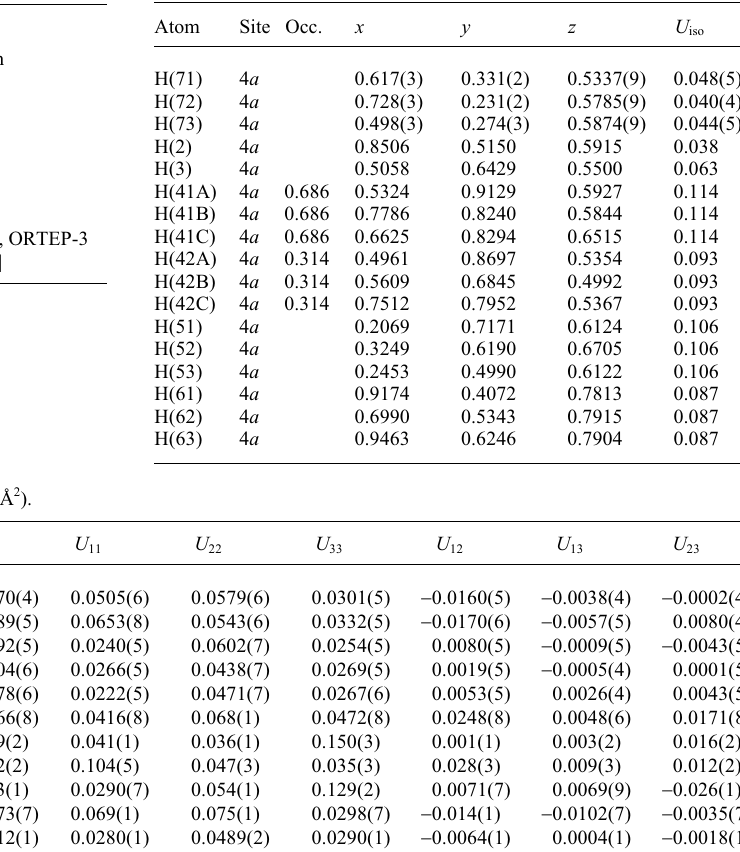
Table 2. Atomic coordinates and displacement parameters (in Å 2 ) . Table 1. Data collection and